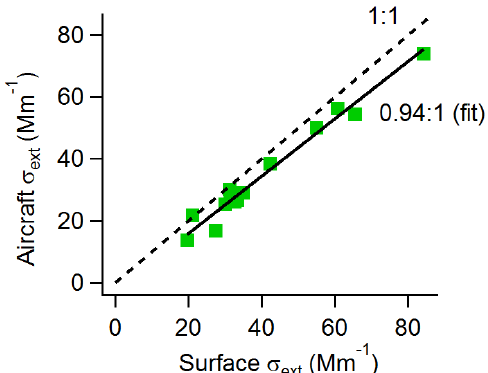
Figure 4. Comparison of airborne and surface measurements of the dry aerosol extinction coefficient. The airborne measurements are aboard the NOAA WP-3 aircraft. The surface measurements are from the SEARCH monitoring